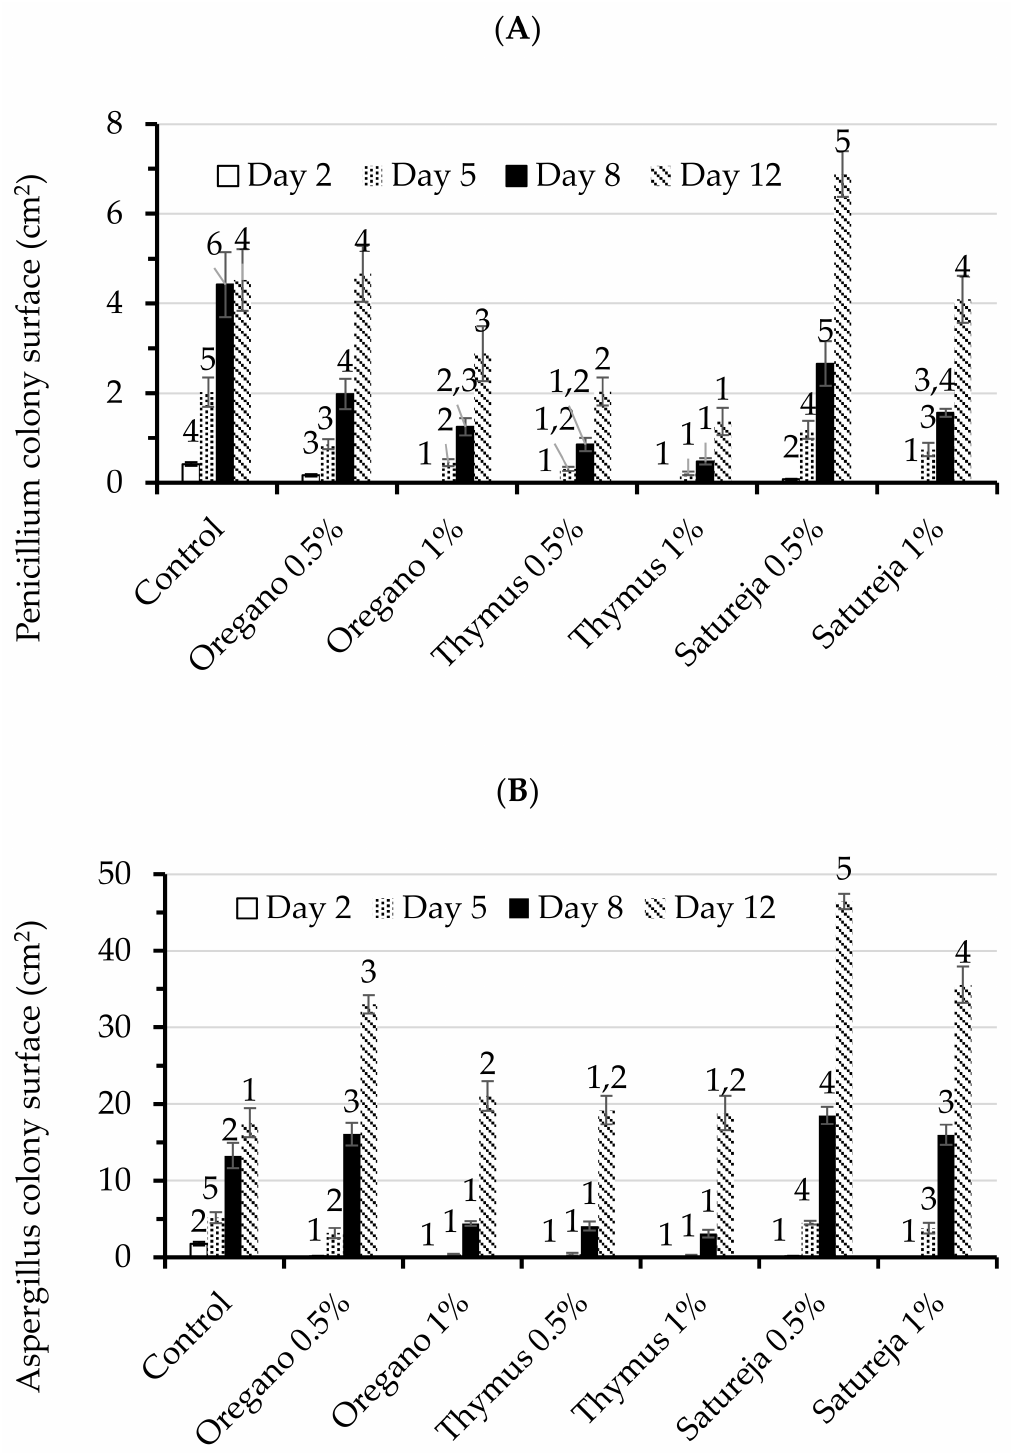
Figure 1. Average growth (cm 2 ) in potato dextrose agar (PDA) medium for ( A ) Penicillium and ( B ) Aspergillus with treatment during 12 days of storage. Similar number superscripts (reported above each column) in the same incubation day are not significantly di ff erent ( p < 0.05) by Duncan’s multiple range